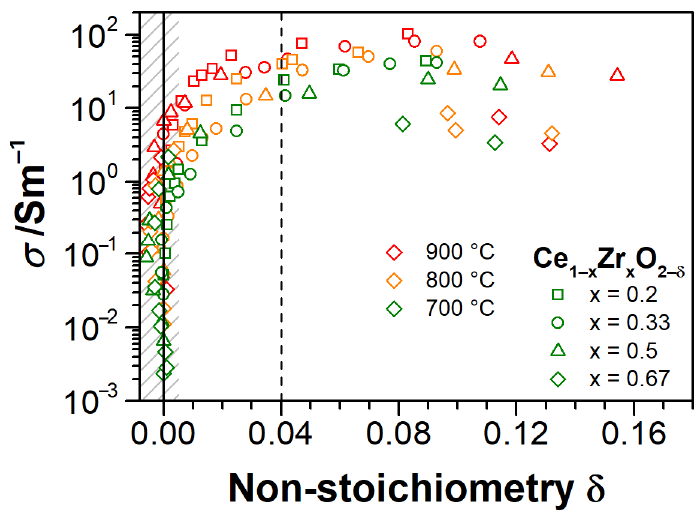
Figure 9. Dependence of the electrical conductivity of Ce 1 − x Zr x O 2 −δ on the oxygen non-stoichiome- try δ . The gray-dashed area in the vicinity of δ = 0 indicates the uncertainty range, in which the non-stoichiometry barely changes with decreasing p O 2 . The line at δ ≈ 0.04 shows the approximate limit, above which the electrical conductivity for all CZO tends to